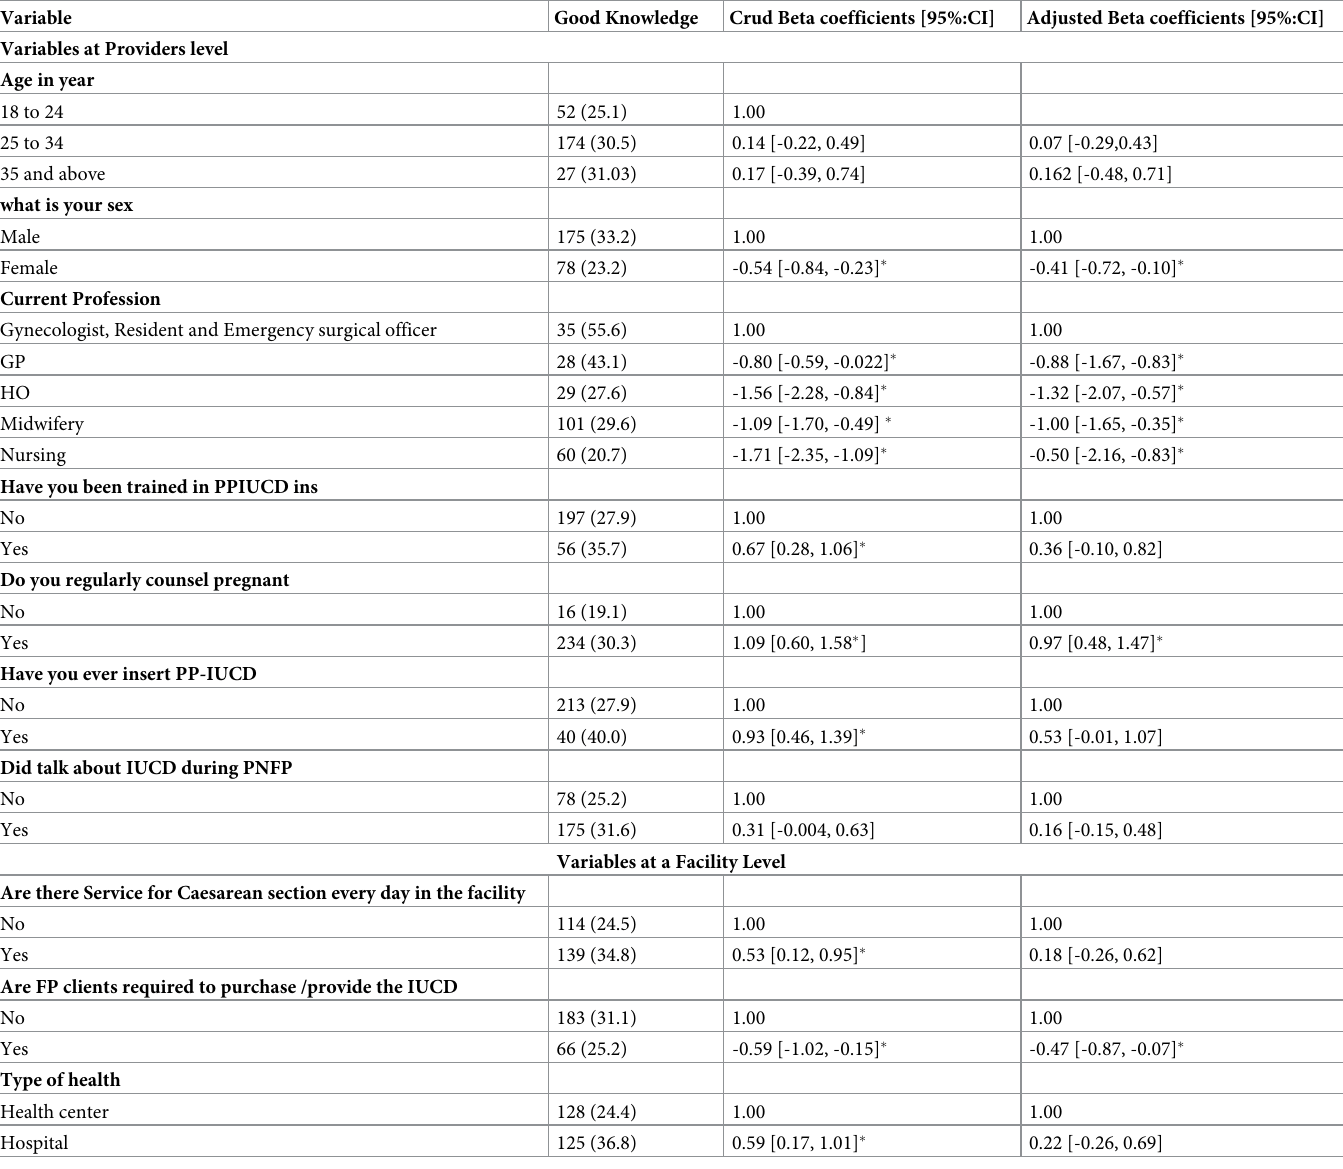
Table 5. Multivariate analysis for factors associated with PP-IUCD Knowledge in Amhara regional state health providers Ethiopia